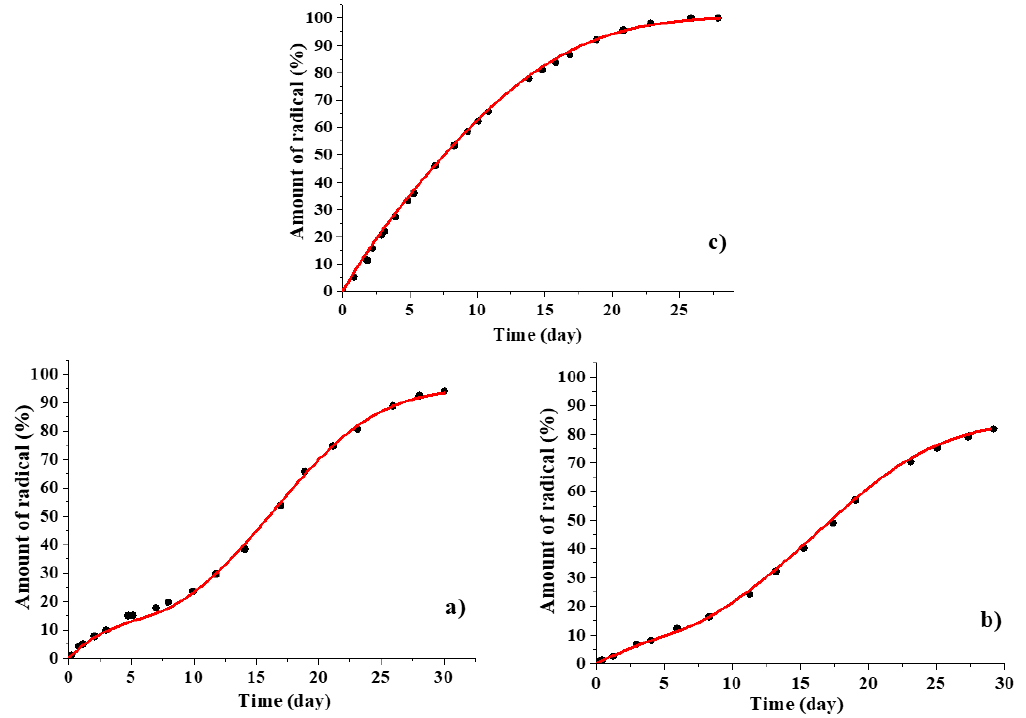
Figure 15. Experimental cumulative curves (dots) and corresponding numerical modeling (lines) of TEMPOL ( a ) and ATI ( b ) release from 200 µ m PDLLA films and of TEMPOL ( c ) release from 50 µ m